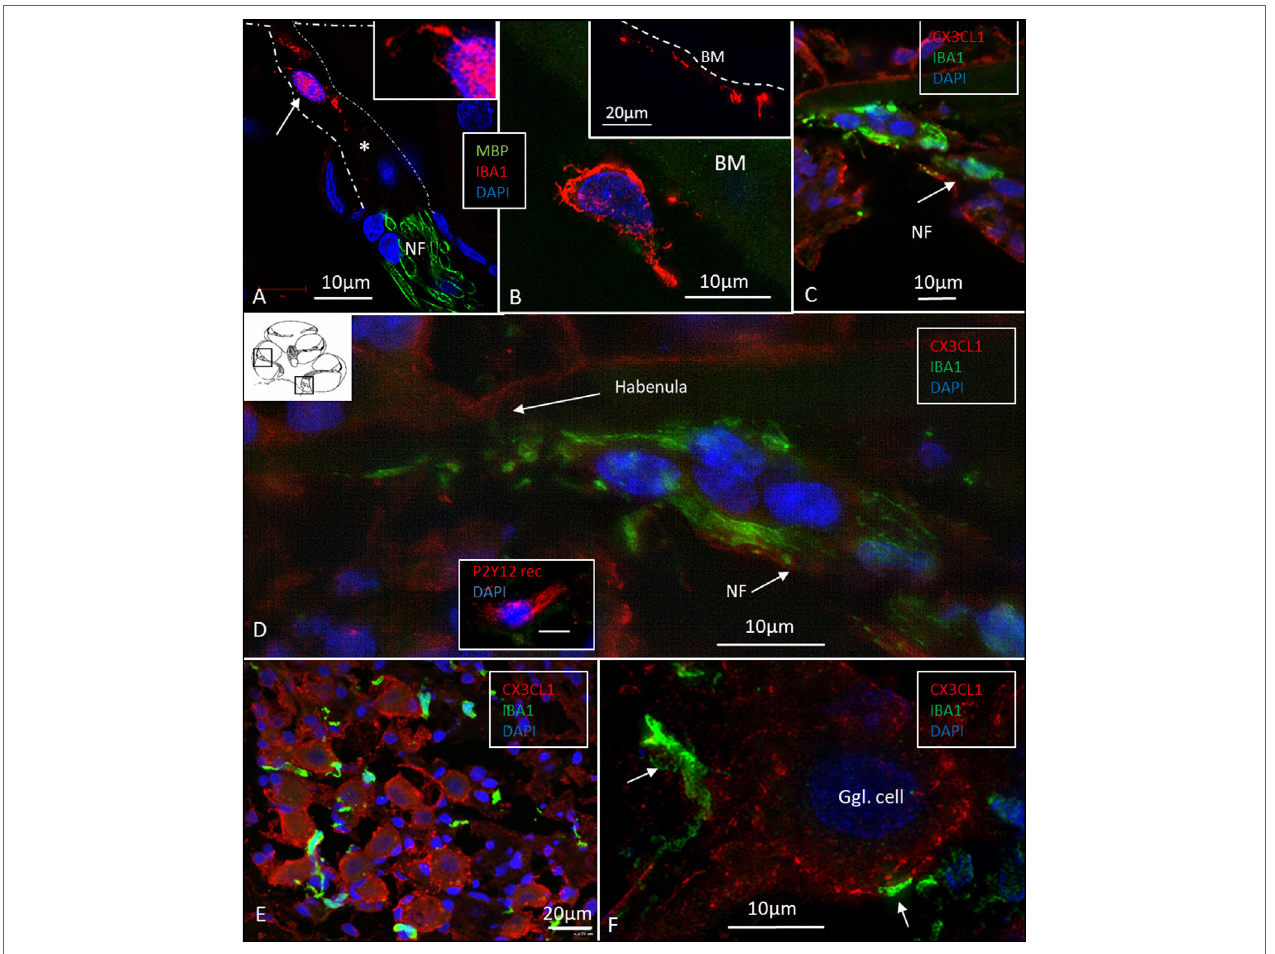
FigUre 7 | Ionized calcium-binding adaptor molecule 1 (IBA1) cells accumulate at habenula perforate and fractalkine is expressed in the spiral ganglion. (a) SR-SIM of IBA1 and myelin basic protein (MBP) expression at the habenula perforata of the human cochlea. A macrophage is shown around the unmyelinated fibers. It has a thin projection against the habenular opening (inset). (b) The tympanic covering layer also contains IBA1-positive cells firmly attached to the inferior surface of the basilar membrane (BM). (c) Confocal microscopy of numerous IBA1-positive cells around unmyelinated portion of the acoustic nerve bundle (arrow). There is no strong fractalkine expression in the organ of corti. (D) Inset in panel (D) shows a cell positive for the P2 Y12 receptor. SR-SIM (maximal intensity projection) at corresponding location showing IBA1 cells with thin projection into the habenular opening. (e) Confocal microscopy of IBA1 and fractalkine expression in the human spiral ganglion (basal turn). (F) SR-SIM (maximum intensity projection) of fractalkine expression with IBA1-positive macrophages surrounding the type I ganglion